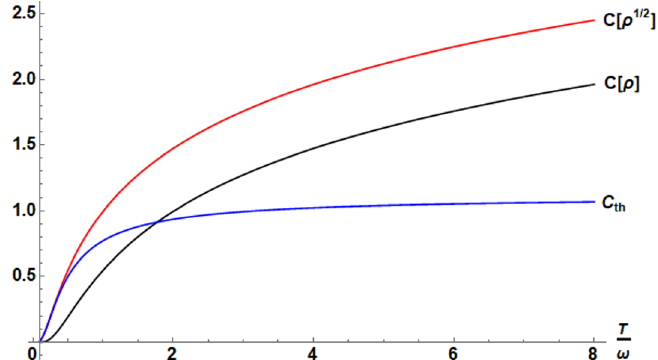
Figure 4. A complexity can be associated with a mixed thermal density matrix ˆ ρ th through the complexity of purification C th (2.2), operator-state complexity of the density matrix C os [ˆ ρ th ] (2.50), and the operator-state complexity of the square root of the density matrix C os [ˆ ρ 1 / 2 discussed in the previous section, the complexity of purification saturates at low frequencies, while the operator-state complexities grow logarithmically with inverse frequency ∼ ln( T/ω )